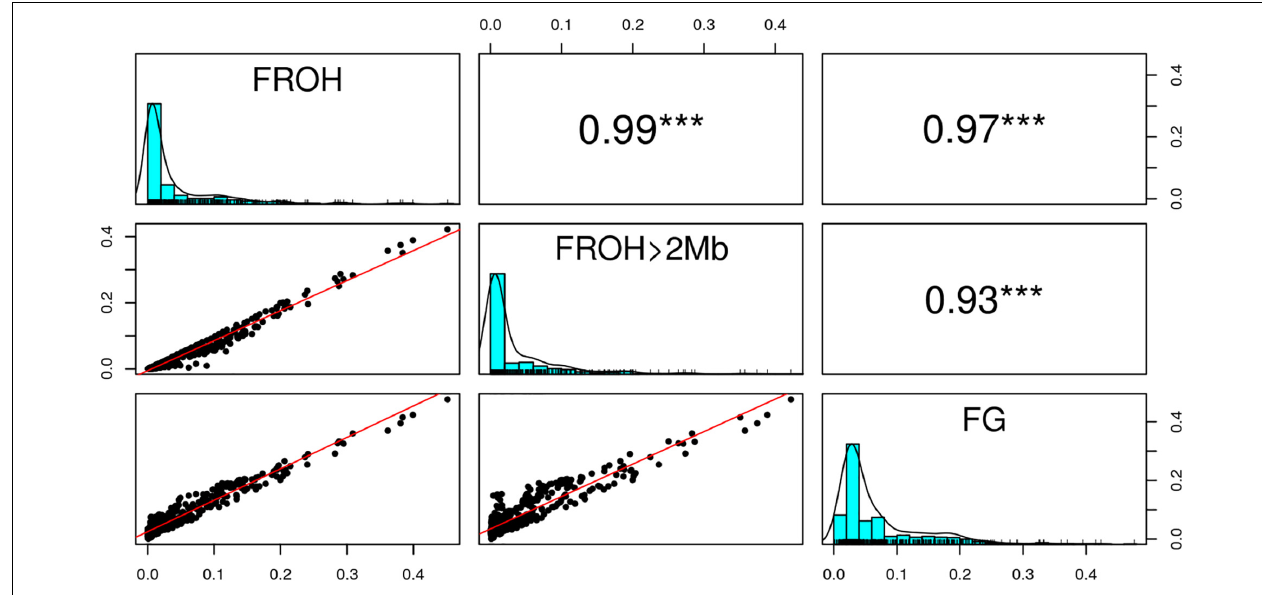
FIGURE 7 | Overall correlation between the inbreeding metrics (F ROH , F ROH > 2Mb , and F G . ∗∗∗ Significant at p < 0.001).